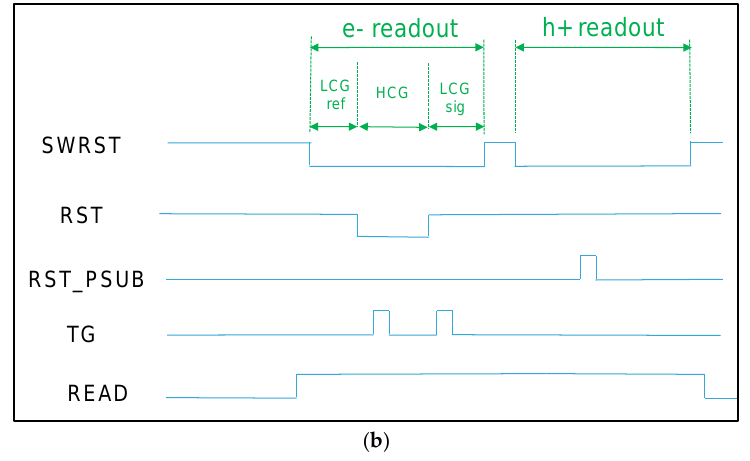
Figure 3. Pixel timing. ( a ) Full timing for low conversion gain mode (LCG); ( b ) readout timing with double conversion gain mode for electron. HCG: high conversion gain.